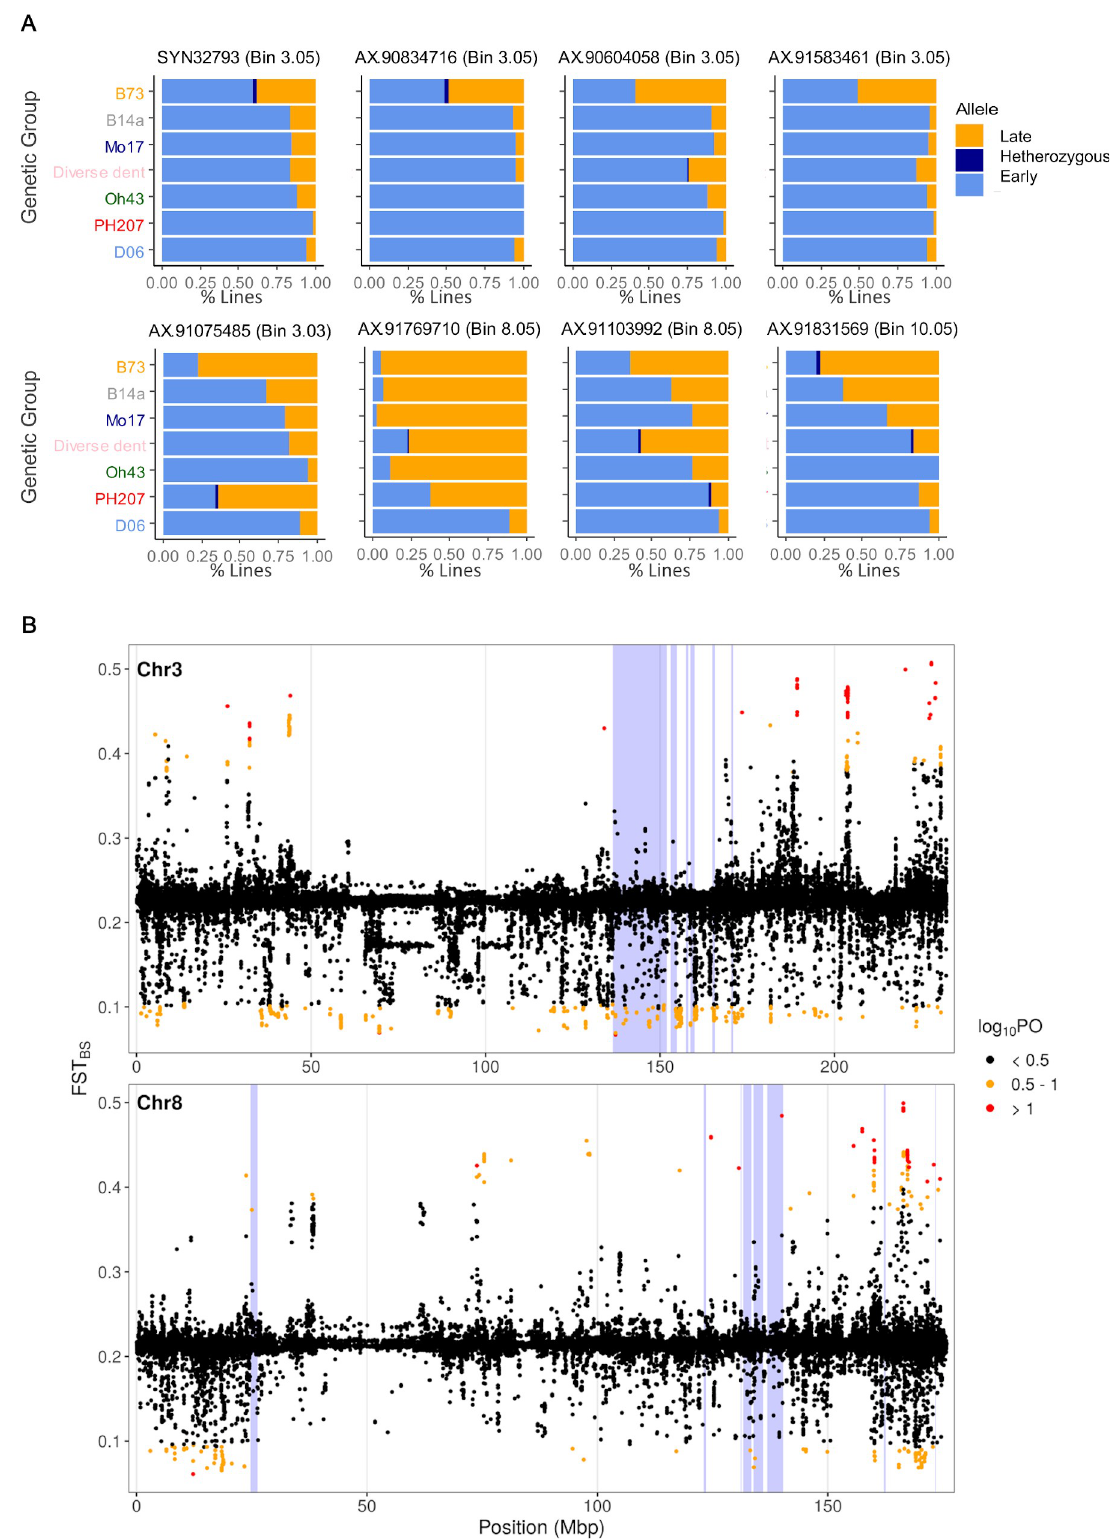
Fig 5. Flowering time precocity of temperate maize derives from selection at ZCN8/12 regulatory regions. (A) Allelic distributions within genetic groups for 8 major QTLs. The SNPs displayed belong to the core set of 19 QTLs common to anthesis in the